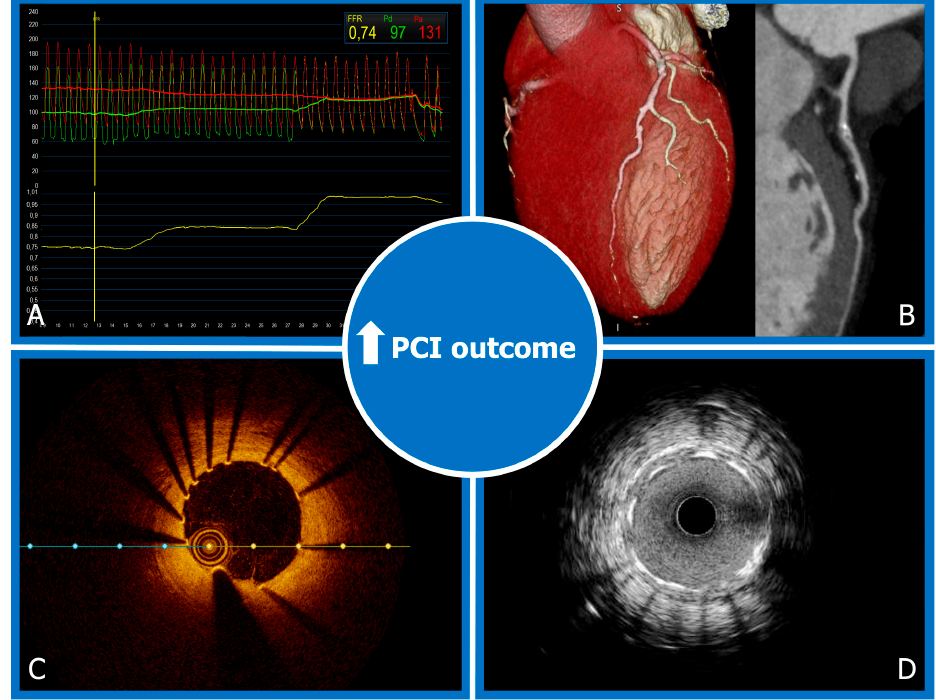
Figure 3. PCI optimization strategies to improve clinical outcome. Physiology assessment with FFR pullback ( A ). Coronary CTA showing anatomical 3D and multiplanar reconstructions ( B ). Post-PCI OCT and IVUS evaluation of stent expansion and apposition ( C , D ).